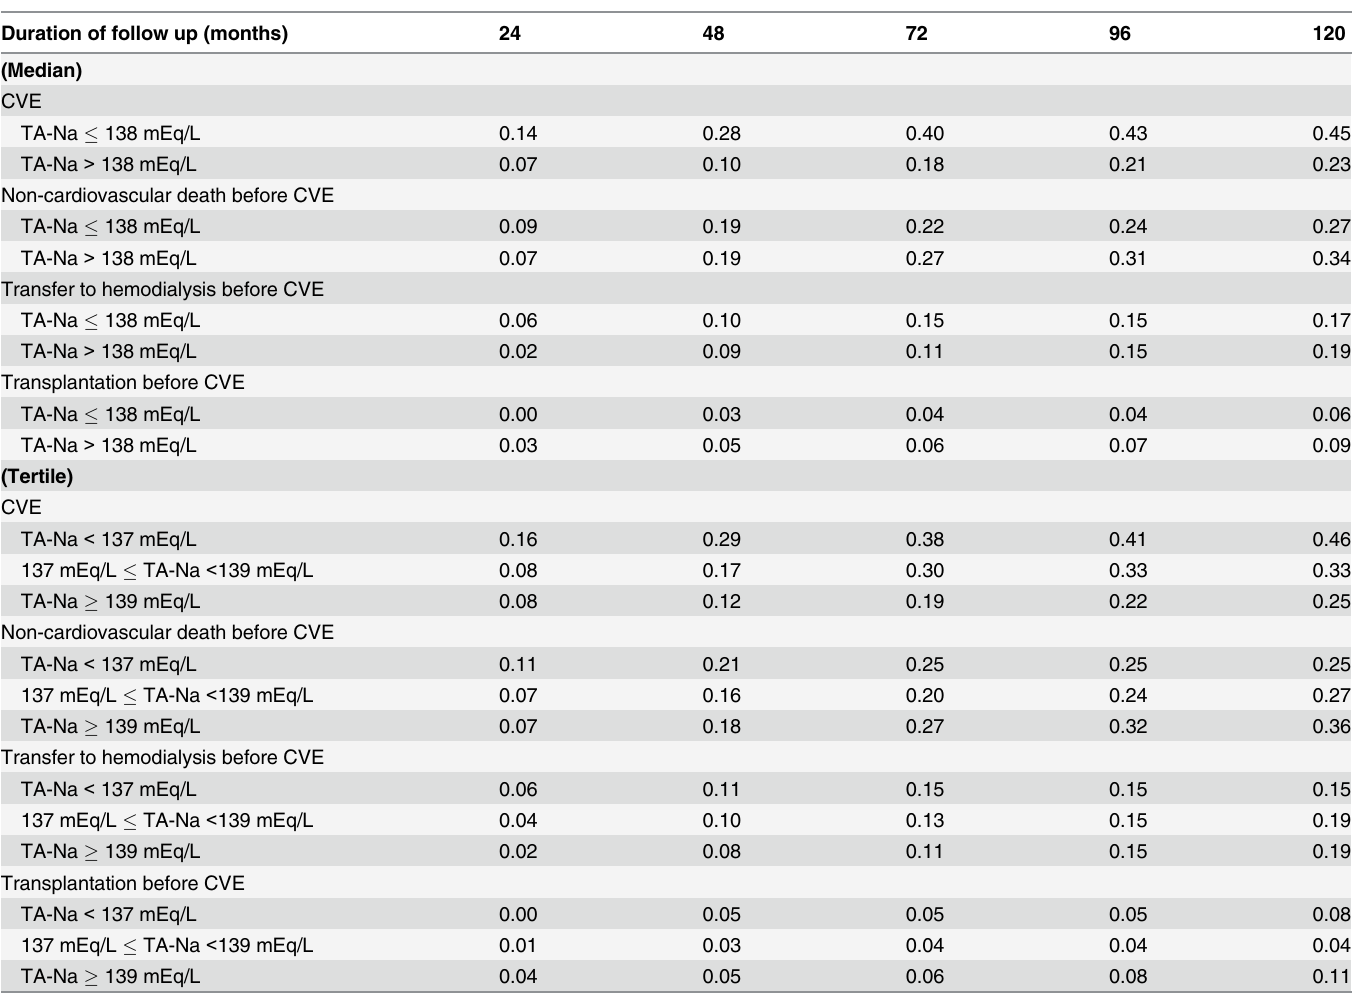
Table 3. Cumulative incidence of a new-onset cardiovascular event and other outcomes.